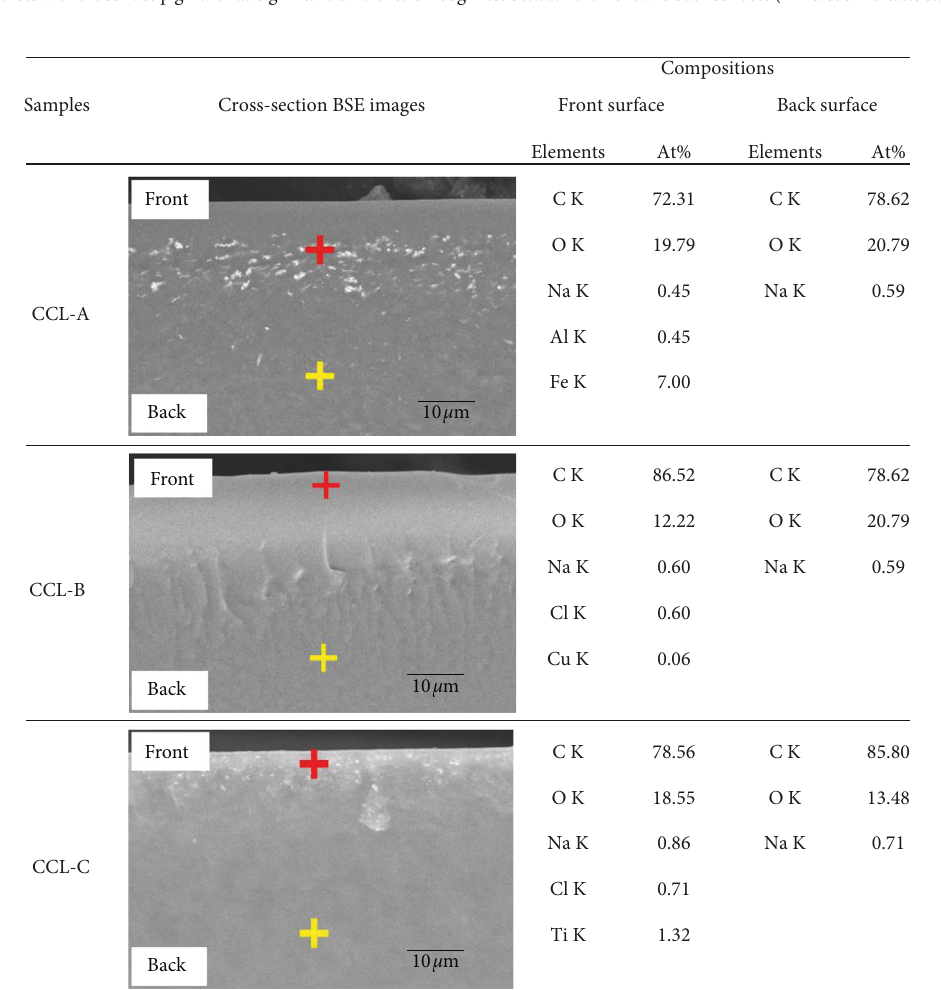
rms ) and average roughness ( R a ) of the brown cosmetic